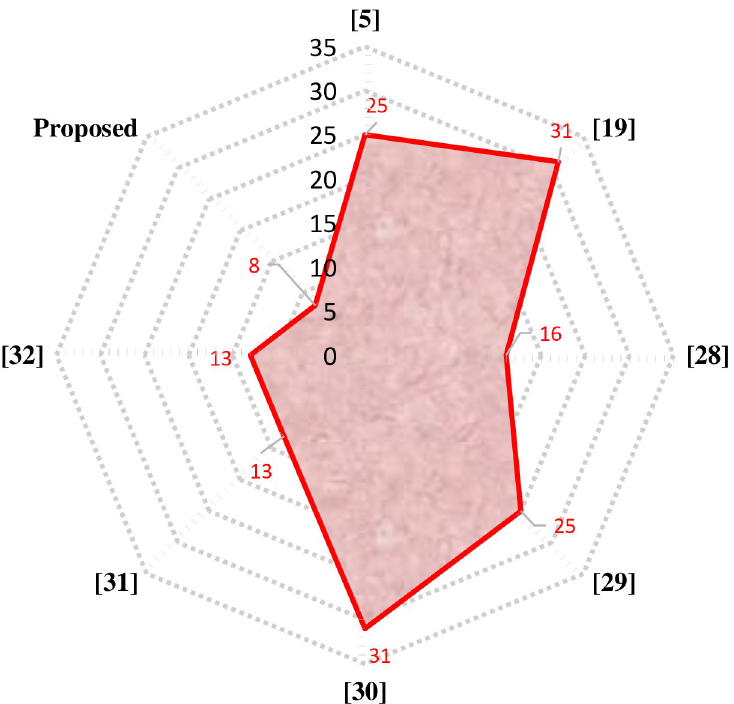
Fig 28. Comparison of 81-level MWMLI with various topologies for the number of isolated gate drivers as a parameter.